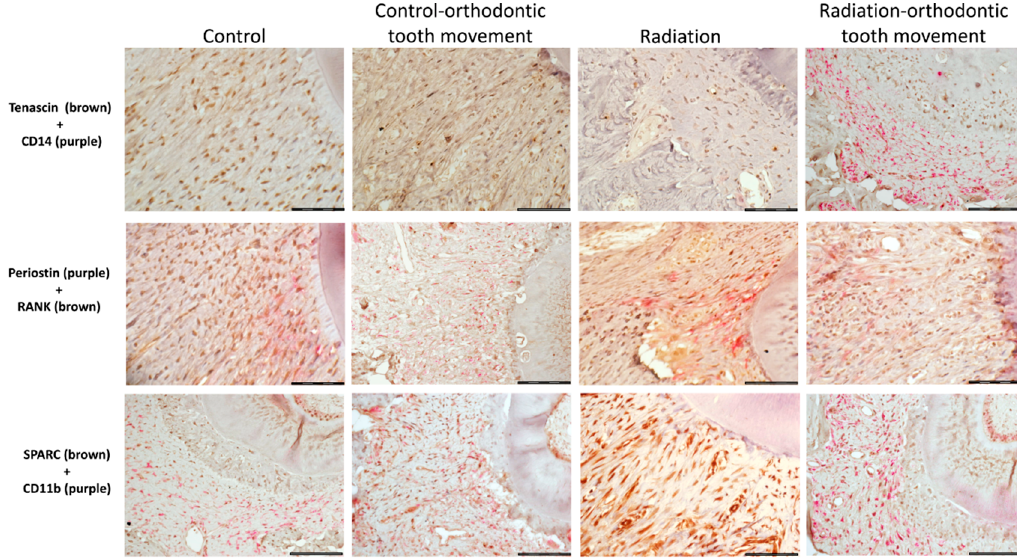
Figure 7. Tension side: representative sections showing the various pairs of double immunohistochemical stains for iden- tification of the expression of pre-osteoclastic and pre-osteoblastic markers in the various study groups (scalebar 50 μ ).